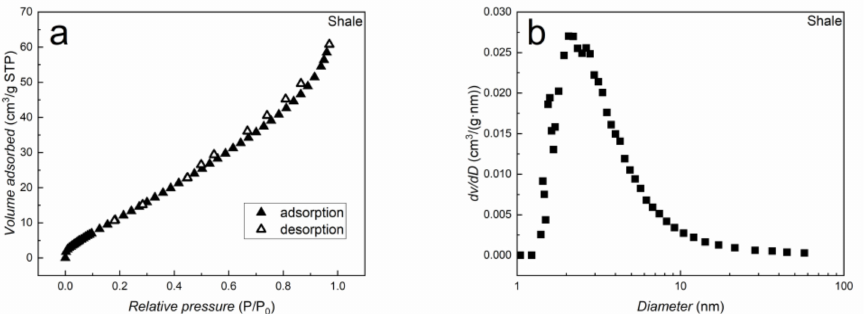
Figure 1. ( a ) N 2 adsorption (solid) and desorption (hollow) isotherms and ( b ) pore size distribution of crushed